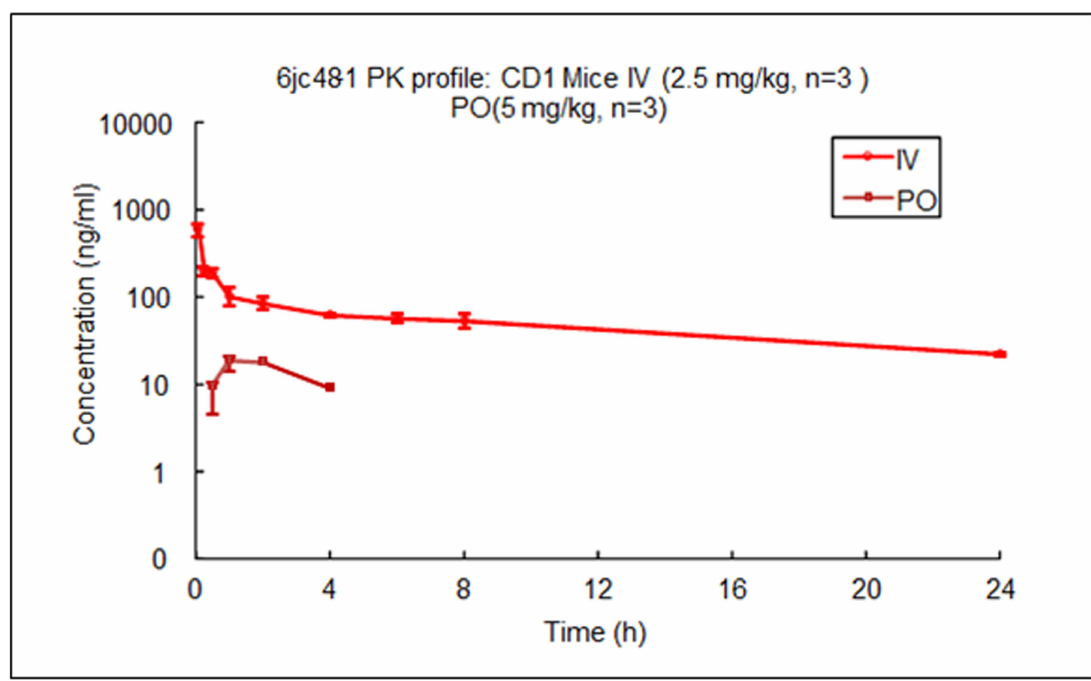
Fig 4. Pharmacokinetics of 6jc48-1 in vivo . Compoundwas administered at 2.5 mg/kg (IV) or 5 mg/kg (PO) to male CD1 mice (n = 3) in 10% DMSO and 50% PEG 400 in PBS. Half-life was determinedby measuringthe plasma concentration of compoundby LC/MS/MS at the time points indicated.